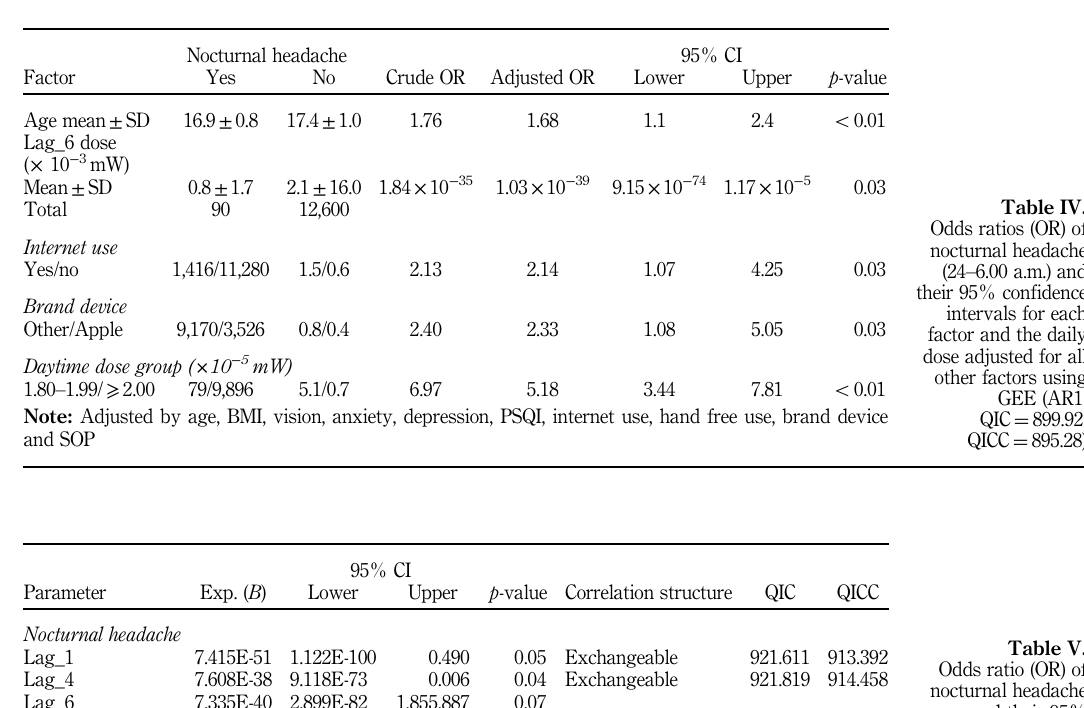
nocturnal headache and their 95% confidence intervals for lag dose adjusted for all other factors using